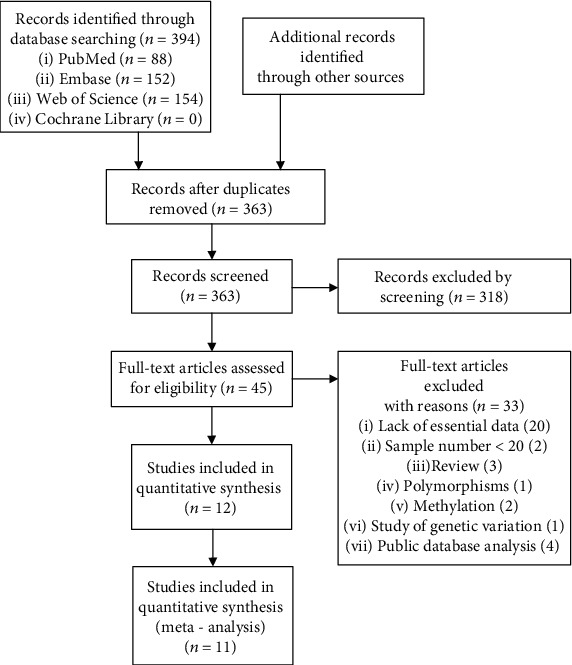
Flow diagram of the process of selection of relevant studies analyzing the prognostic value of period family in cancer.